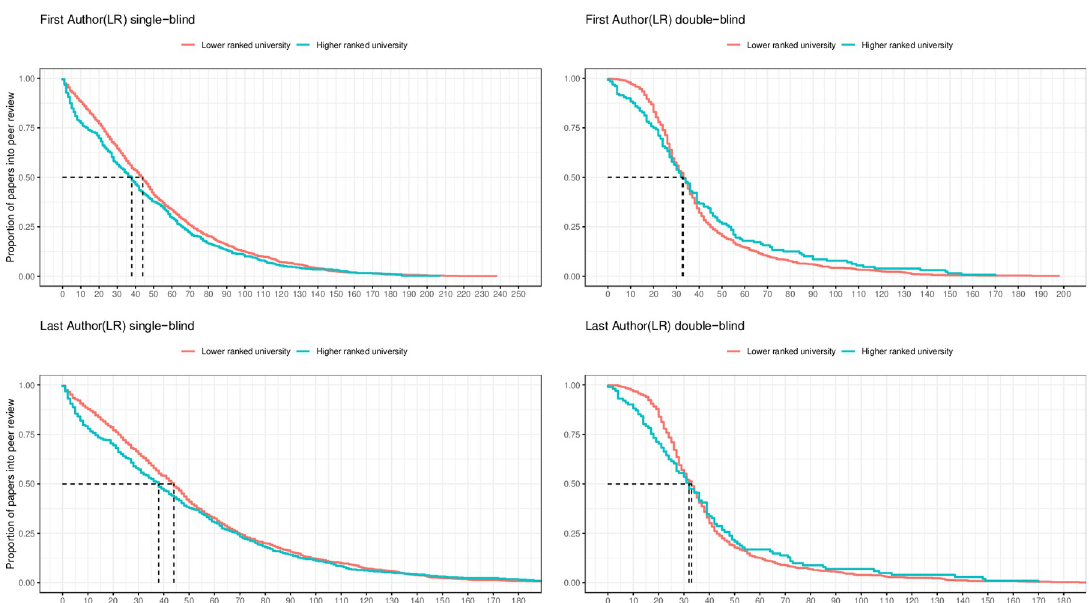
Fig 3. Survival plots of time from submission to publication for COVID-19 papers published in single-blind versus double-blind peer reviewed journals, authored at higher-ranked (teal line) versus lower ranked universities (red line). The groups of highly ranked and lower ranked universities are inferred from the Leiden Ranking. Dashed black lines specify the difference in median review times of papers from highly ranked and lower ranked universities.